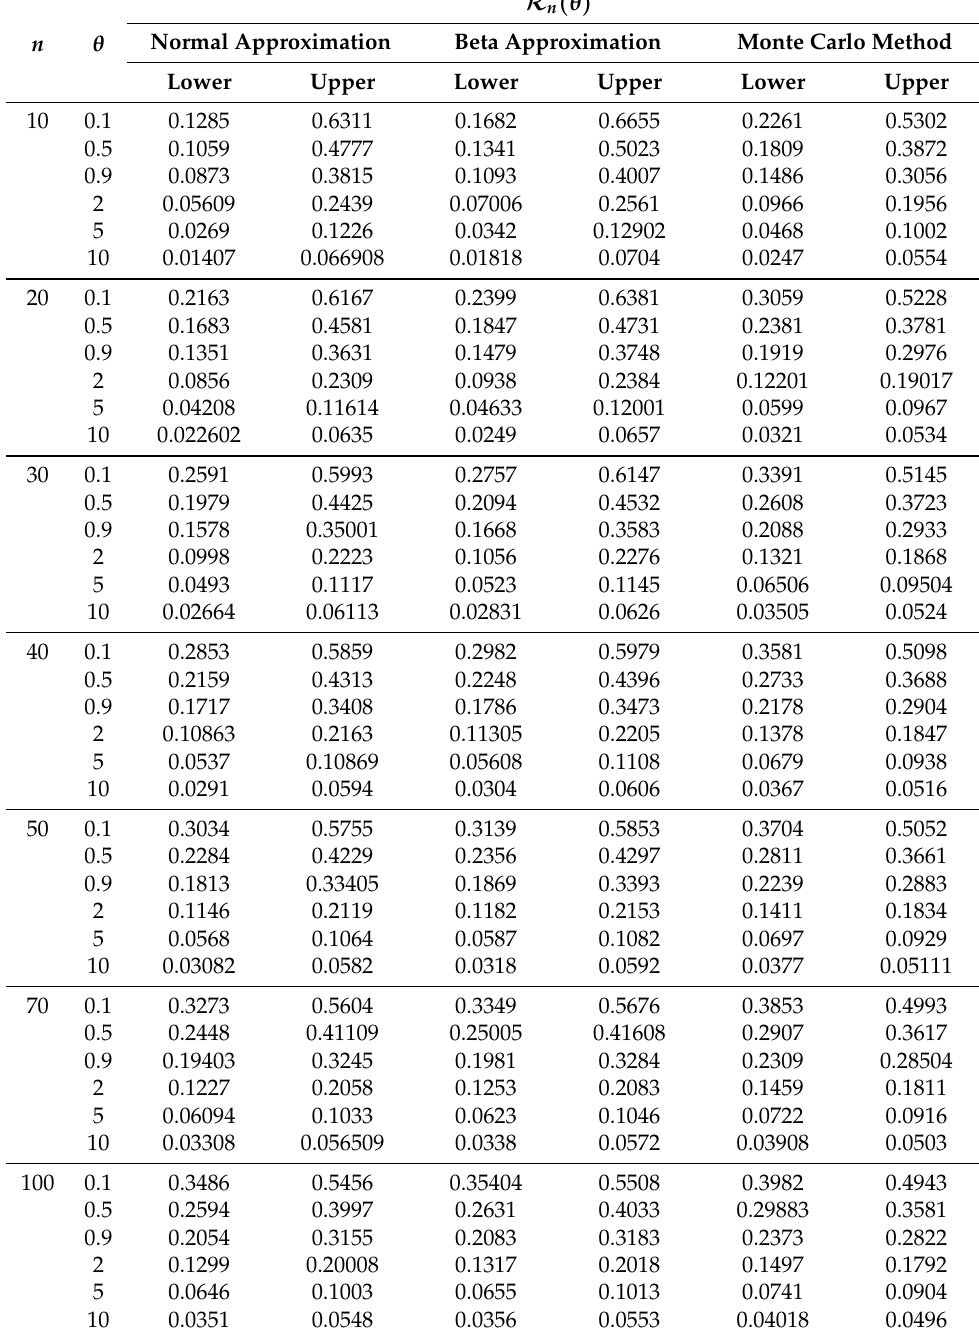
Table 1. Percentage points of the suggested test statistic R n ( θ ) at level α =